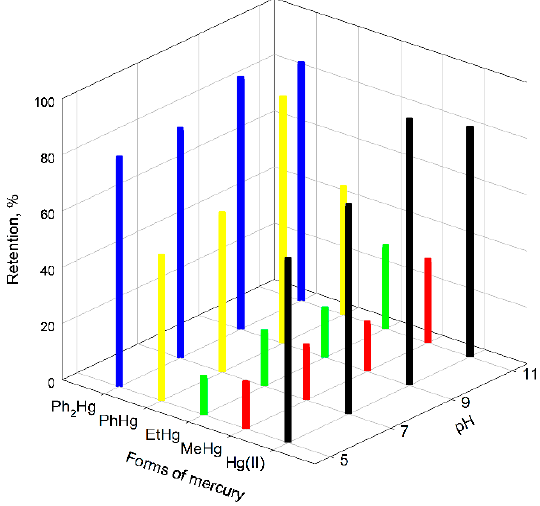
Figure 2. Retention of different forms of mercury in Fe 3 O 4 @GO at different pH values.